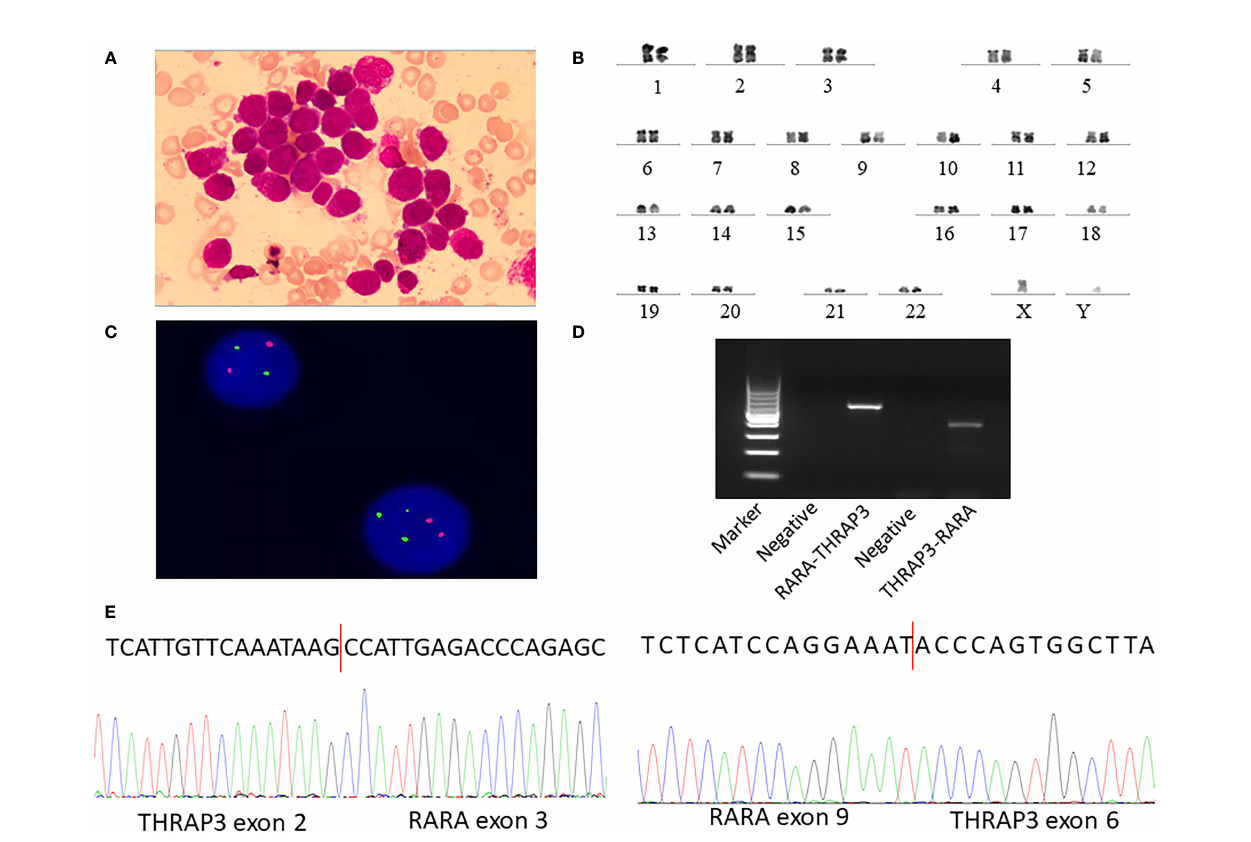
FIGURE 1 | Identi fi cation of novel recurrent fusions RARA-THRAP3 in APL lacking t(15;17) (q22;q12)/PML-RARA. (A) Several promyelocytes, with hypergranulated cytoplasm and invaginated nuclei, are shown in the diagnostic bone marrow (BM) aspirate (Wright – Giemsa stain, ×1,000). (B) A karyotype performed on the diagnostic BM revealed 46, XY [20]. (C) Fluorescence in situ hybridization using RARA dual color probes found RARA rearrangement or the split RARA signals. Intact RARA are shown as (red) and (green), while the abnormal RARA signals are indicated as (yellow). (D) Electrophoresis of RT-PCR products from the patient showed the RARA-THRAP3 fusion transcript, whereas the reciprocal THRAP3-RARA transcript were also detected. (E) Partial nucleotide sequences surrounding the junctions of the RARA-THRAP3 fusion transcript. The RARA-THRAP3 fusion transcript was a fusion of THRAP3 exon 9 and RARA exon 6 genes. The THRAP3- RARA fusion transcript was a fusion of THRAP3 exon 2 and RARA exon 3 genes.